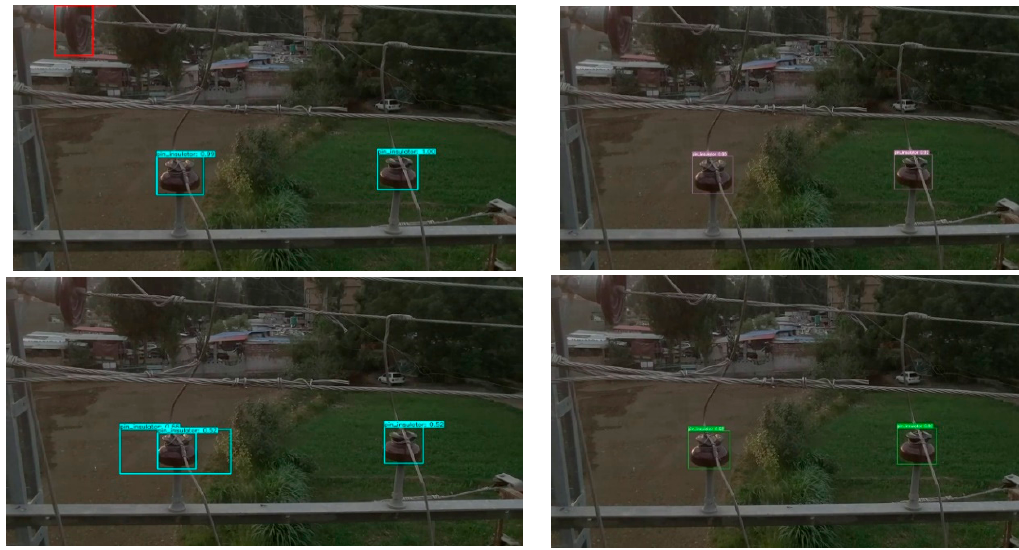
Figure A3. Test dataset ( a ), complex (C) ( b ), low light (R-1) ( c ), aerial image with better visibility ( d ), Prototype-C ( e ), Prototype-S, ( f ) variants of a low-light image with LIME.